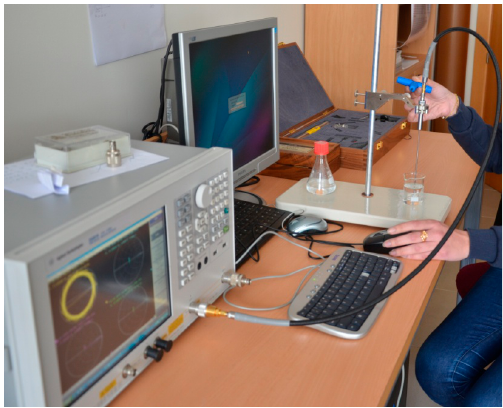
Figure 6. Keysight 85070E dielectric probe used for measurement of dielectric properties .